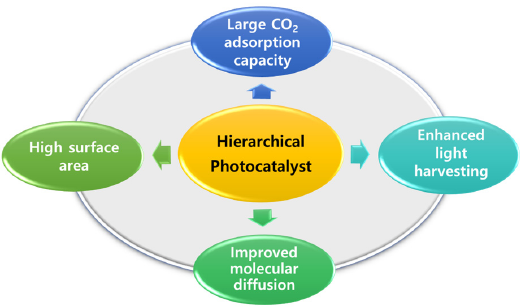
Figure 1. Important features of hierarchical nanostructures.